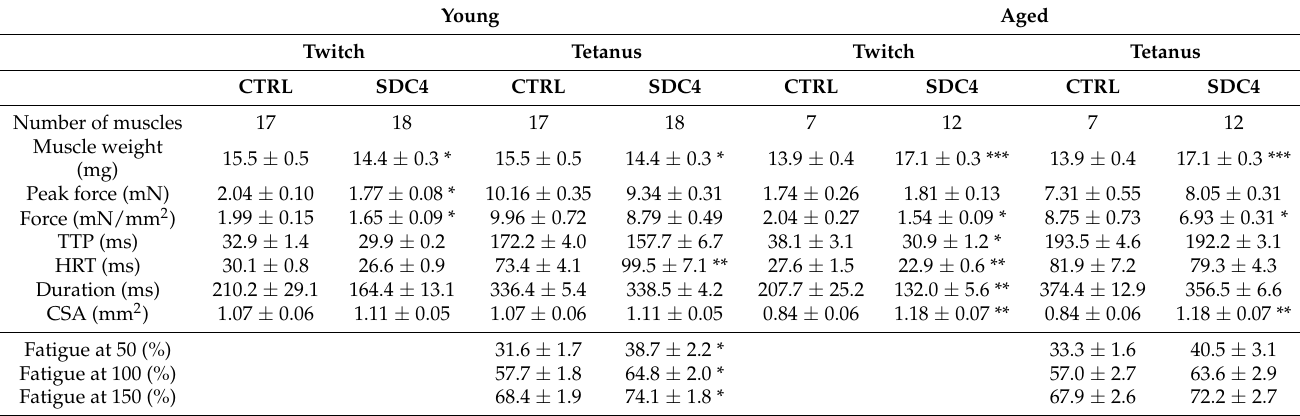
Table 3. Parameters of twitch and tetanus in EDL.